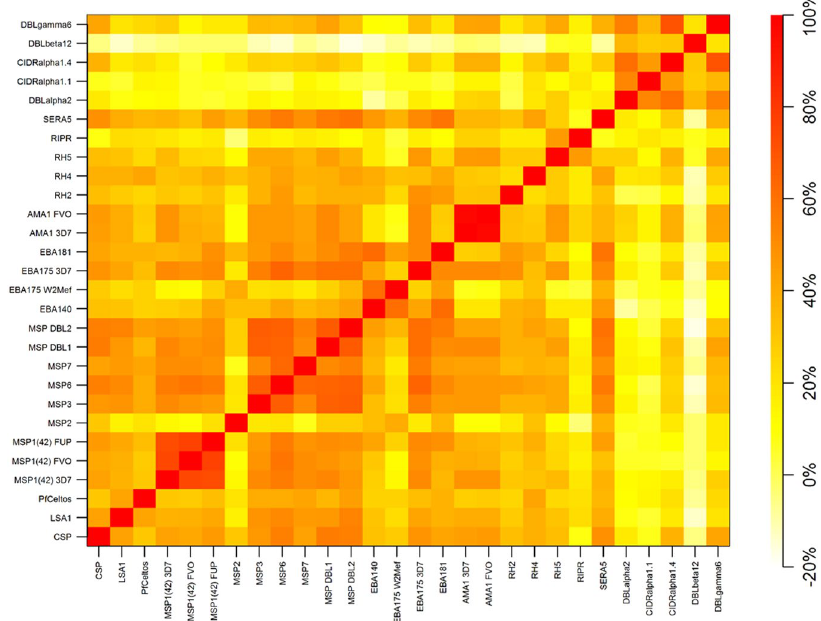
Figure 5. Heat map of correlation of antibody levels for two-way comparisons of 28 Plasmodium falciparum antigens. Increasing intensity of yellow to orange to red coloring correlates with an increasing degree of correlation between antibody